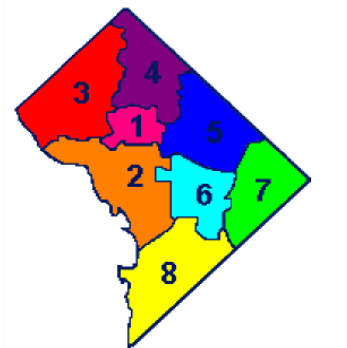
Figure 1: Washington, DC Wards